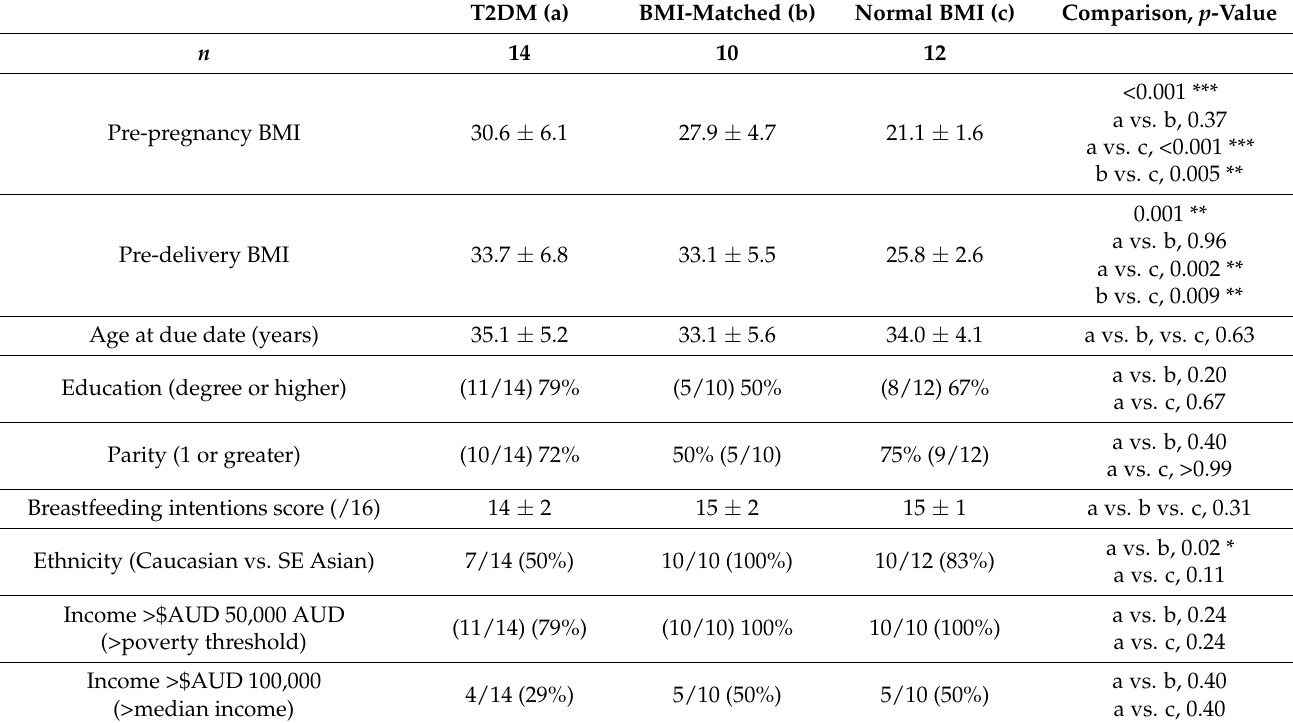
Table 1. Pre-Delivery Data: Women Who Provided Breastmilk For